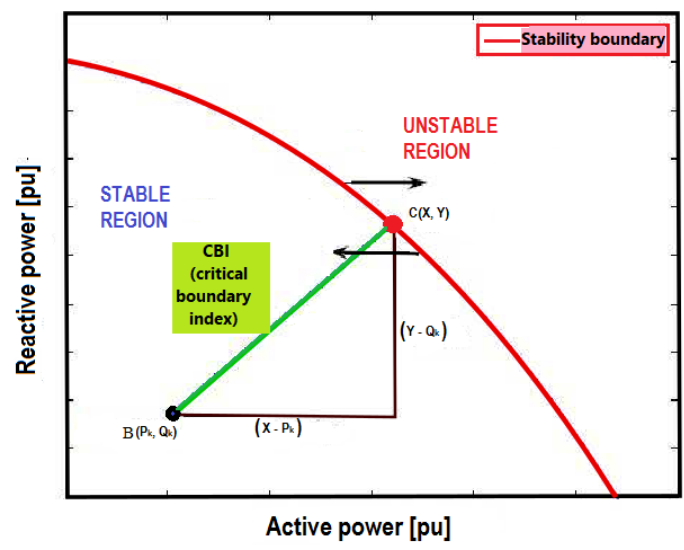
Figure 3. P-Q curve showing the voltage stability margin.